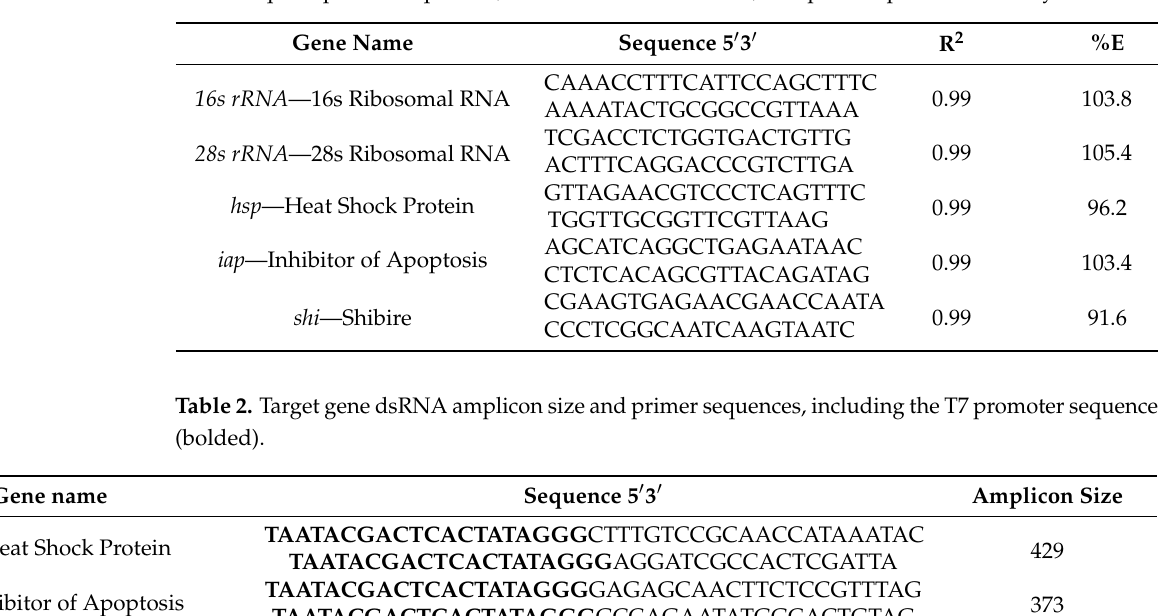
Table 1. qPCR primer sequences, R 2 correlation coefficient, and percent primer efficiency.